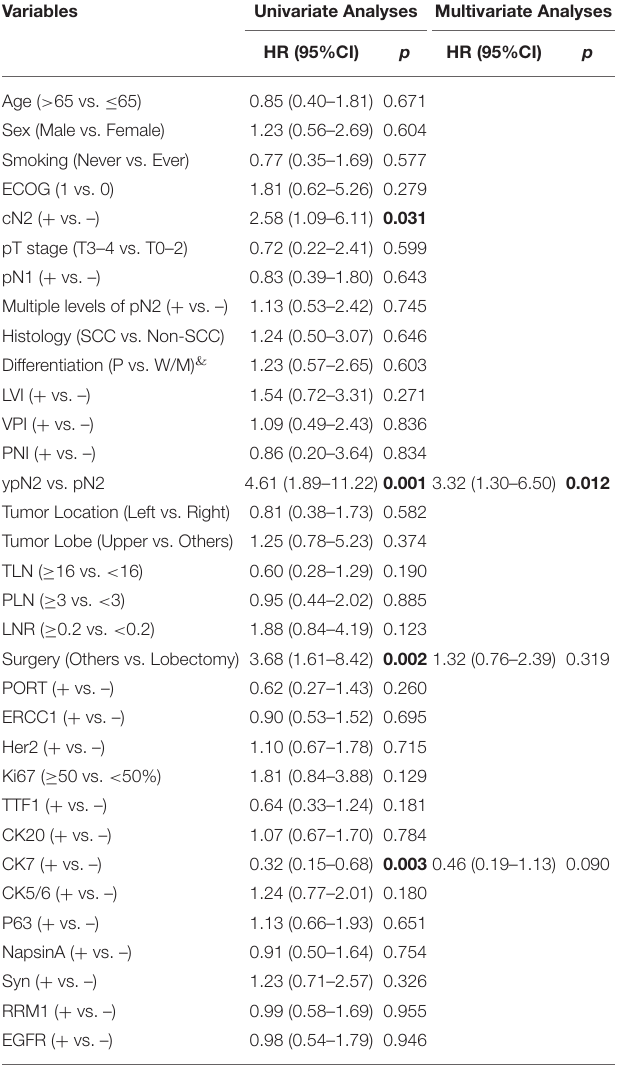
TABLE 2 | Competing risk analyses of clinical-pathological variables associated with supraclavicular recurrence.